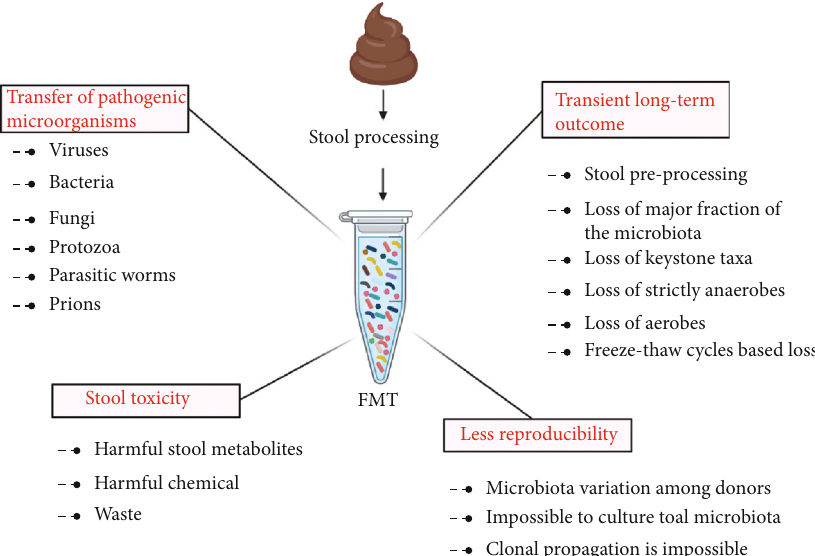
Figure 2: Disadvantages and limitations of conventional FMT. Various disadvantages include pathogen transfer, transient results, stool toxicity, and di ffi culty in